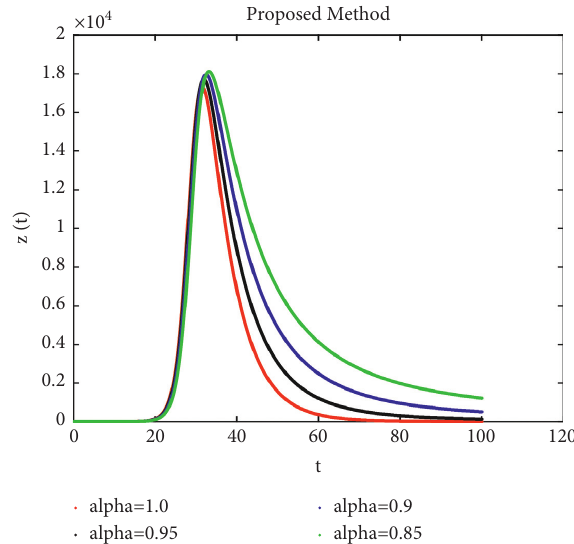
Figure 5: Dynamical behavior of free HIV virus particles at α � 1 and various fractal order under power law kernel.